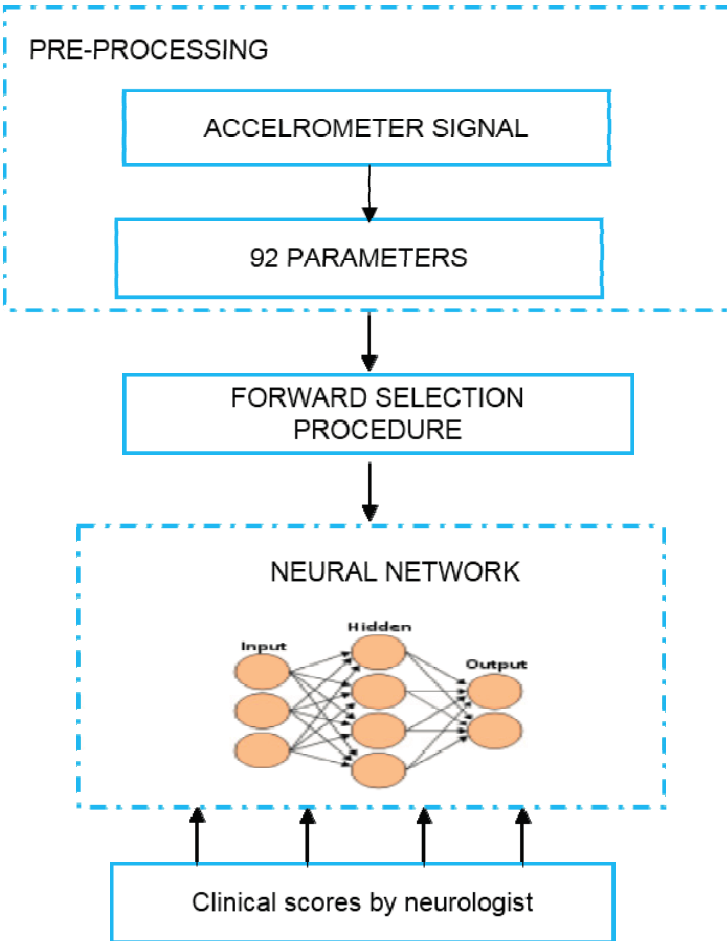
Figure 7. An overview of the methodology of dyskinesia severity